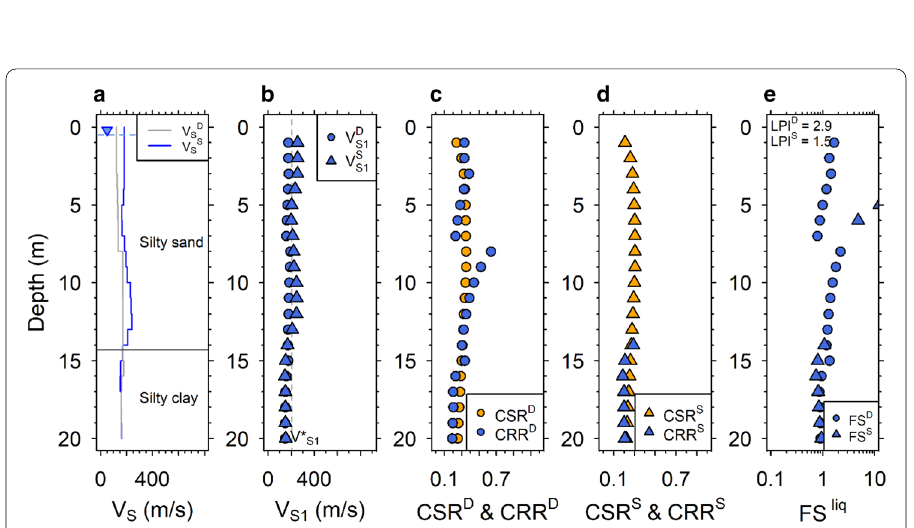
Fig. 6 Profiles of a V S S and V S D ; b V S 1 ; c CSR D and CRR D ; d CSR S and CRR S ; and e FS D and FS S at Site 4, where sand boils were observed (liquefied). The LPI is shown in at the top right of ( e ). The silty clay at a depth of 16 m has a fines content of